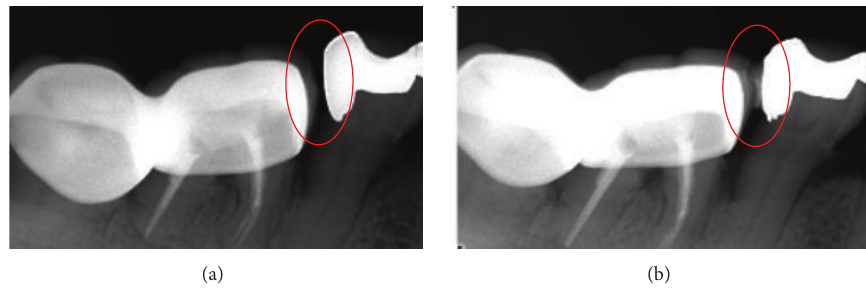
Figure 7: X-ray diagnosis of the interproximal contact area before (a) and after (b) the